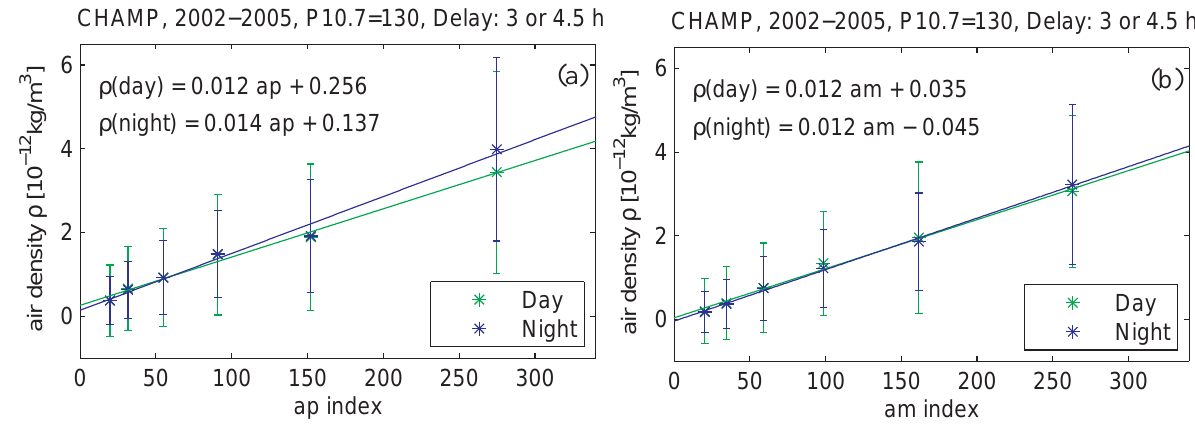
Fig. 11. The dependence of the density on magnetic activity, as represented by the indices a p and a m , is shown in frames (a) and (b) , respectively. A linear fit to the medians of each bin was applied (solid lines). The error bars indicate the standard deviation of the values within a